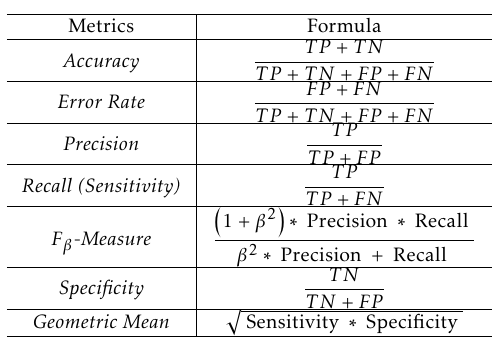
Table 3. Evaluation Metrics based on Confusion